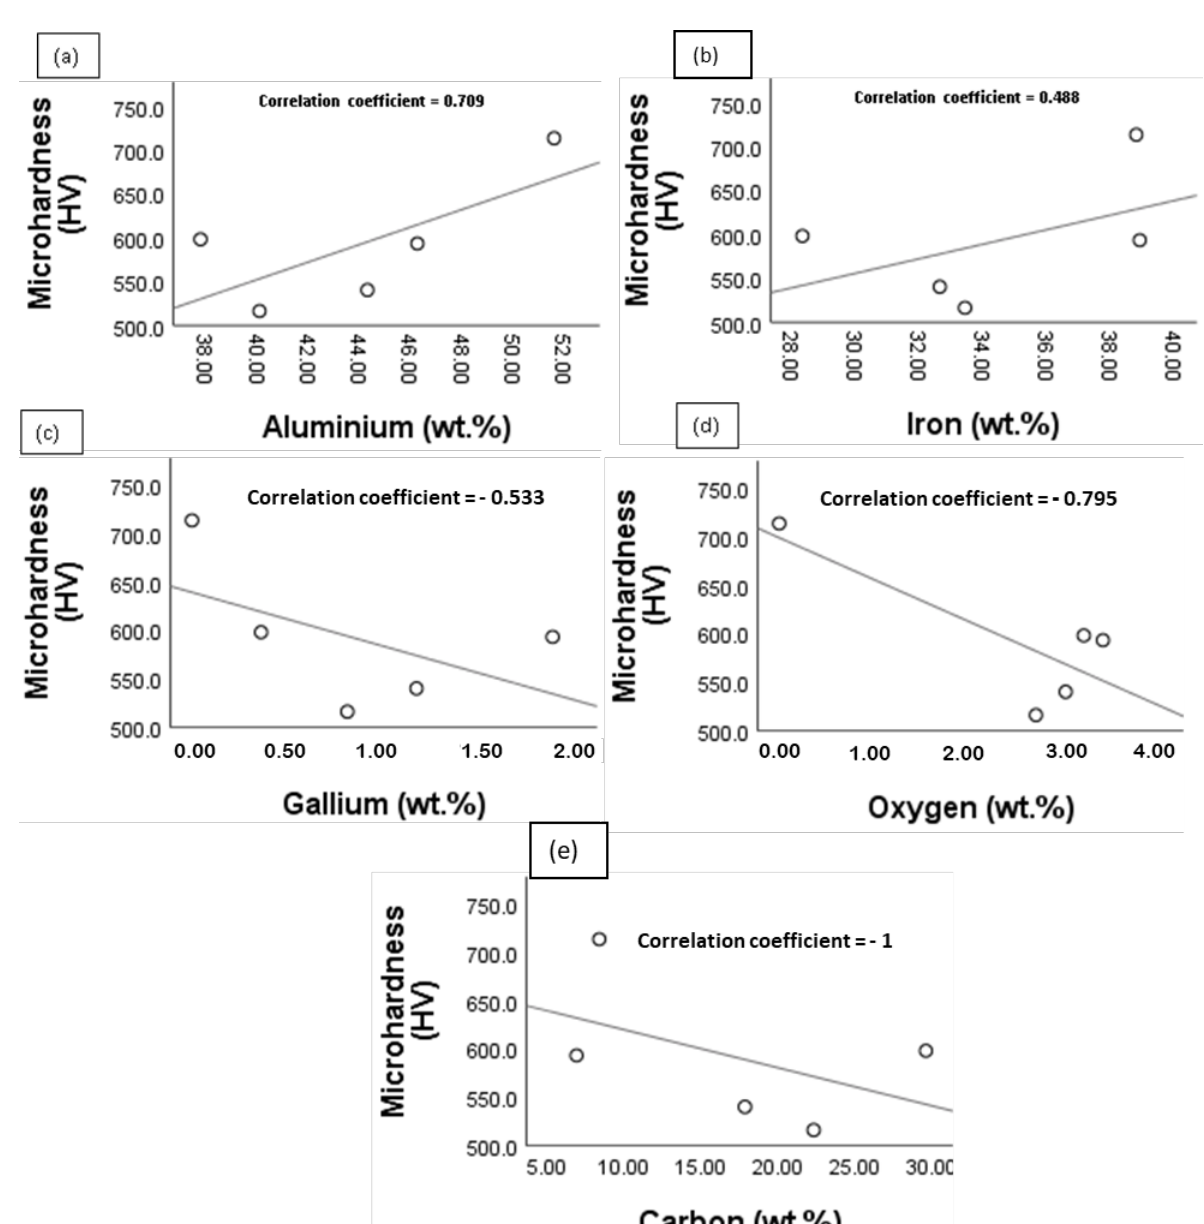
Figure 15. Scatter plot of the microhardness against the elemental composition (wt.%) of the reaction layer: ( a ) Microhardness against Al; ( b ) Microhardness against Fe; ( c ) Microhardness against Ga; ( d ) Microhardness against O; ( e ) Microhardness against C.